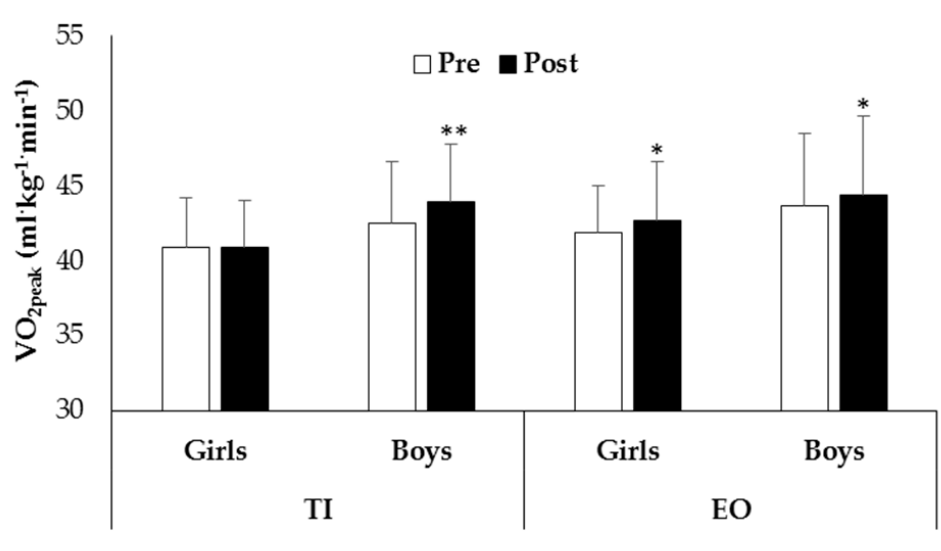
Figure 3. VO 2peak of girls and boys before (Pre) and after (Post) intervention in experimental outdoor intervention (EO) and traditional indoor intervention (TI) (* p = 0.01, ** p = 0.001). The main effect of time revealed that children’s shifting platforms test (F 1,101 = 78.03, p < 0.0001, η 2 = 0.436) (30.6 ± 9.2 score vs. 38.3 ± 10.0 score), balance beam test (F 1,101 = 123.60, p < 0.0001, η 2 = 0.550) (33.2 ± 16.4 score vs. 46.8 ± 16.3 score), jumping laterally test (F 1,100 = 119.24, p < 0.0001, η 2 = 0.544) (22.6 ± 15.2 score vs. 41.6 ± 20.7 score), and hopping on one leg test (F 1,101 = 123.61, p < 0.0001, η 2 = 0.550) (36.5 ± 18.2 score vs. 48.7 ± 16.2 score) signifi- cantly increased after intervention. The main effect of group (F 1,101 = 3.10, p = 0.049, η 2 = 0.038) revealed that the EO group had a higher balance beam test score than the TI group (42.2 ± 18.2 score vs. 37.0 ± 16.7 score, respectively). The main effect of gender (F 1,101 = 7.55, p = 0.007, η 2 = 0.070) revealed that girls had a higher balance beam test score than boys (44.0 ± 17.0 score vs. 36.1 ± 17.7 score, respectively). The time × group interaction revealed that the EO group showed a greater increase of balance beam (F 1,101 = 5.61, p = 0.020, η 2 = 0.053) and jumping laterally (F 1,101 = 6.79, p = 0.011, η 2 = 0.064) tests than the TI group after intervention (Table 2). Moreover, subgroup analyses revealed that the shifting platforms test of all boys and girls significantly increased after intervention, however girls of the EO group showed the greater increase (Figure 4).